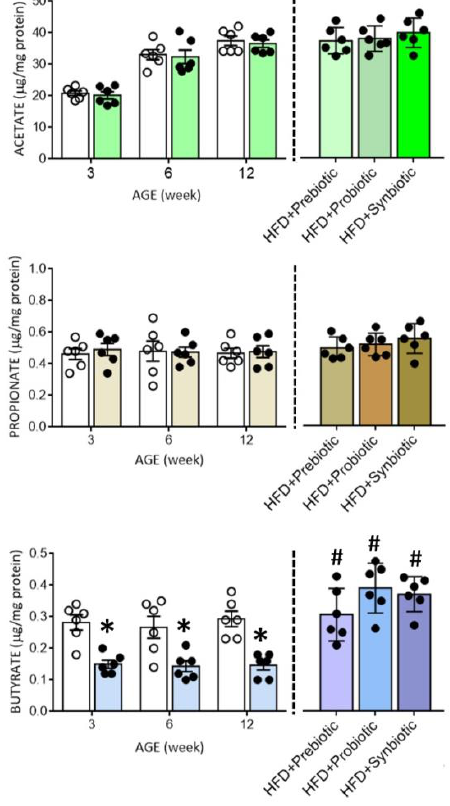
Figure 3. Tissue levels of acetate, propionate, or butyrate in the hypothalamic paraventricular nucleus (PVN) of ND (open circles) or HFD (filled circles) offspring at the age of 3, 6, and 12 weeks or at 12 weeks after additional oral supplementation of FOS (4 g/kg/day, probiotic), L. gasseri (3 × 10 6 CFU/mL/day, probiotic) or FOS+ L. gasseri (synbiotic) was initiated at the age of 6 weeks. Data are presented as mean ± SD, n = 6 in each group. * p < 0.05 vs. ND group, and # p < 0.05 vs. HFD group in the post hoc Tukey’s multiple-range